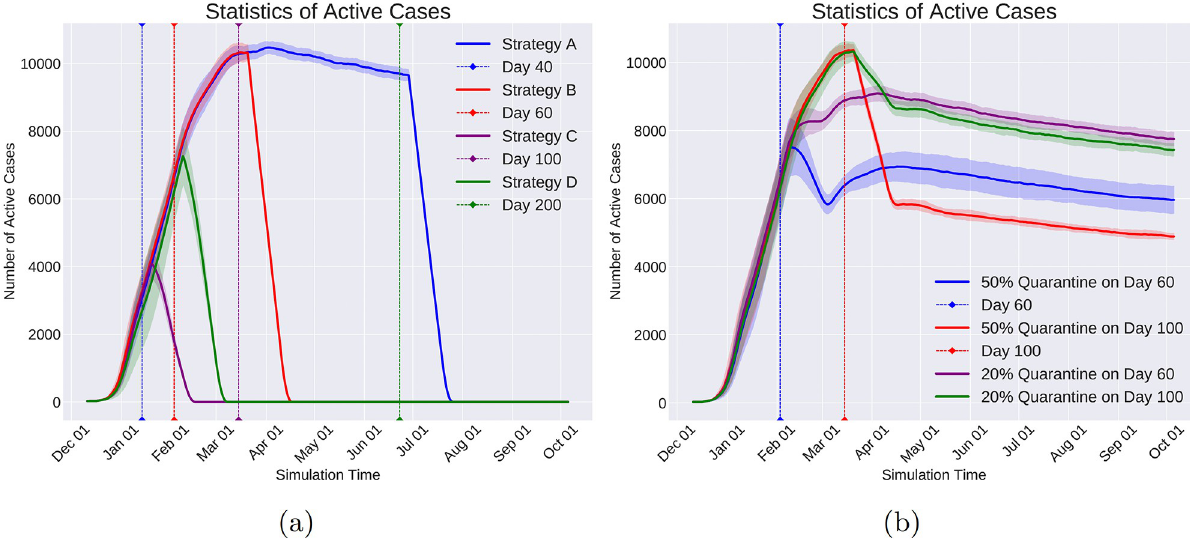
Fig 13. a) This experiment focuses on enforcing universal quarantines (isolating every infected individual after detection) on a specific day after the outbreak. Here, the quarantines are applied both before and after the day when the curve of the active cases reaches its peak. Strategies A, B, C, and D enforce a quarantine at 200, 100, 40, and 60 days after the outbreak, respectively. b) This experiment studies the effect of partial quarantine where a specified ratio of currently infected individuals are isolated at a specified date (i.e., the control measure is triggered by a time point condition). The partial quarantine represents a real-world scenario where there is uncertainty in detecting the infected individuals, which can be caused by numerous reasons such as inaccurate test kits or individuals with mild symptoms that do not visit hospitals or test